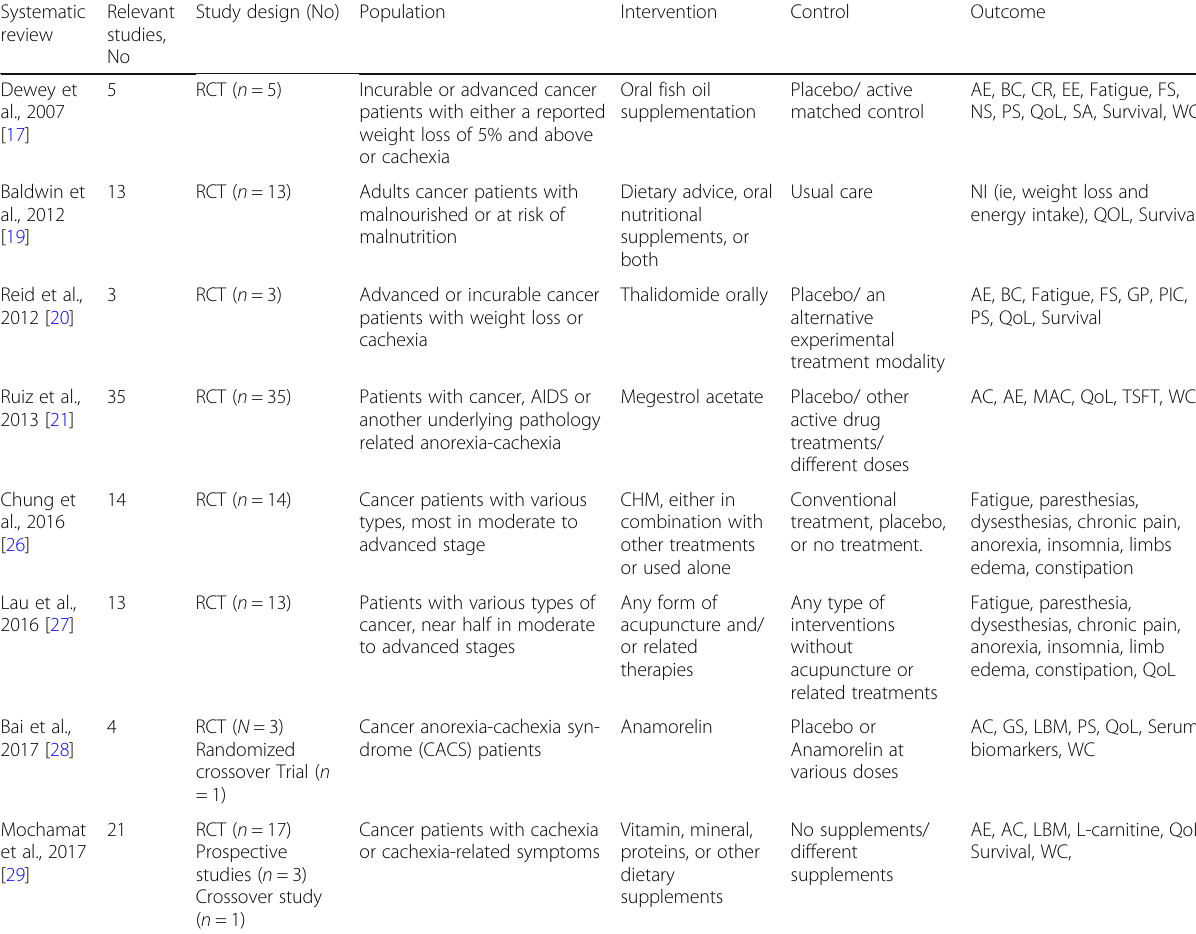
Table 2 Characteristics of systematic reviews Systematic